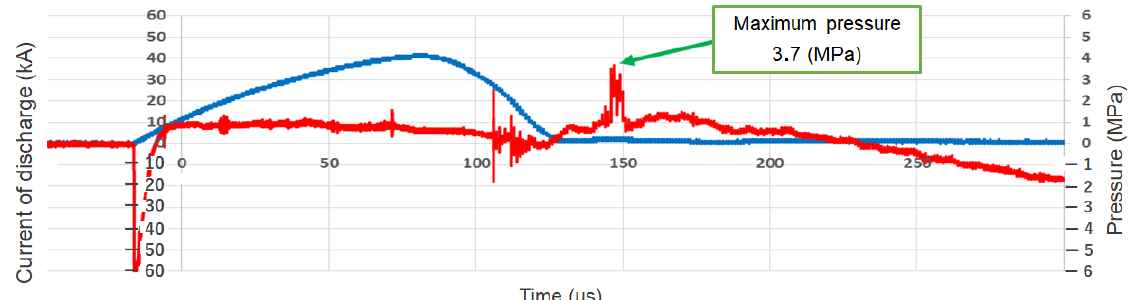
Figure 9. Underwater shock pressure at a position 40 mm from the electrode, and measurements of current flowing to the electrode.